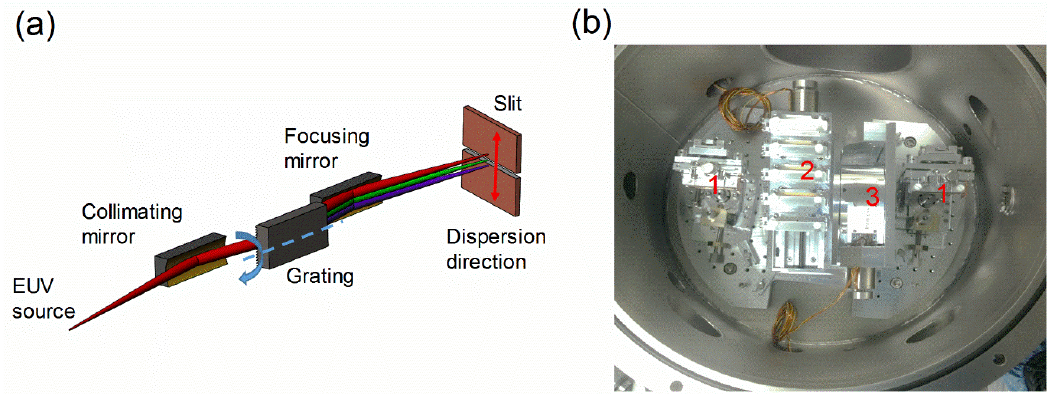
Figure 4. EUV monochromator. ( a ) off plane mount geometry; ( b ) laboratory picture: (1) toroidal mirrors; (2) gratings mounted on translation stage; (3) grating rotation stage. Table 1. Characteristics of the monochromator gratings. The energy resolution has been calculated on a 100- µ m slit